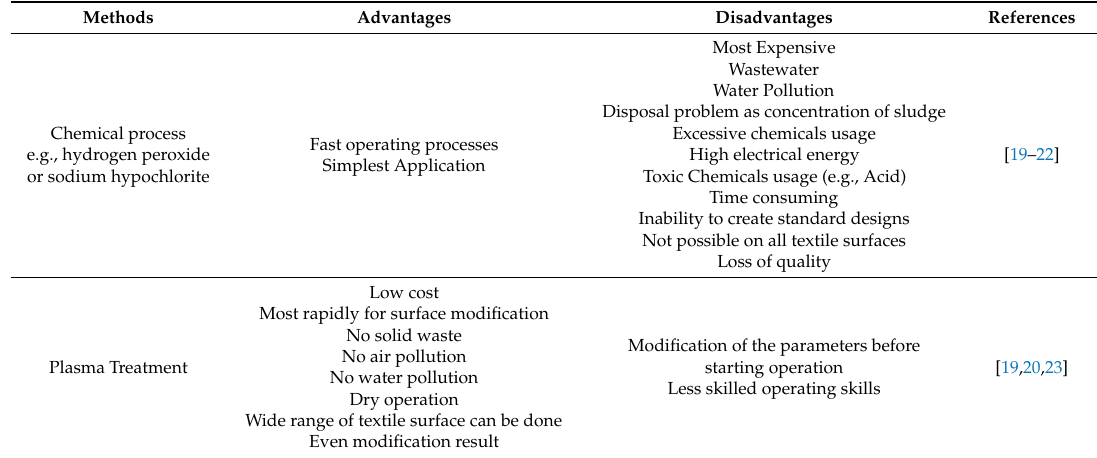
Table 1. Comparison of plasma treatment over conventional wet chemical processes